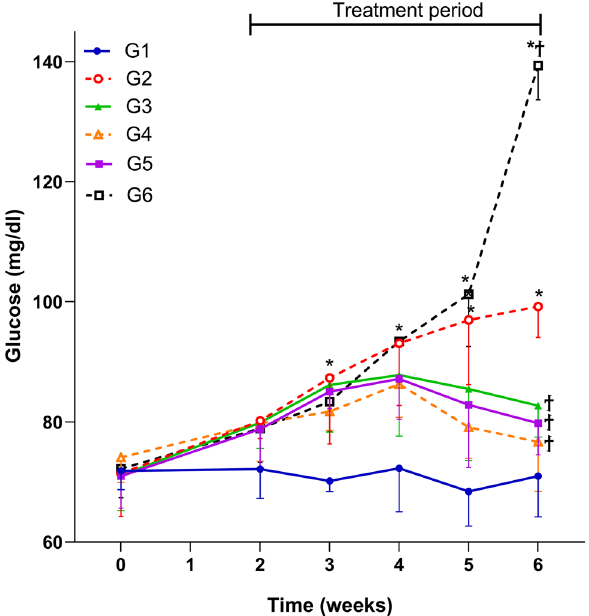
Fig. 2 Effect of BMME on serum glucose. Group 1 (G1), rats were fed ND and treated with normal saline; Group 2 (G2), negative control, rats were fed HCFD and treated with normal saline; Group 3 (G3), positive control, rats were fed HCFD and treated with 20 mg/kg b.w. of atorvastatin; Group 4 (G4), rats were fed HCFD and treated with 10 mg/kg b.w. of BMME; Group 5 (G5), rats were fed HCFD and treated with 30 mg/kg b.w. of BMME; Group 6 (G6), rats were fed HCFD and treated with 100 mg/kg b.w. of BMME. Data for the first week were not collected. Data are expressed as means ± S.E.M. and are analyzed by one-way ANOVA followed by Fisher’s LSD test. Data are expressed as means ± S.E.M. and are ana- lyzed by one-way ANOVA followed by Fisher’s LSD test. *Significant when compared to the normal control group; ϯ significant when compared to the negative control group